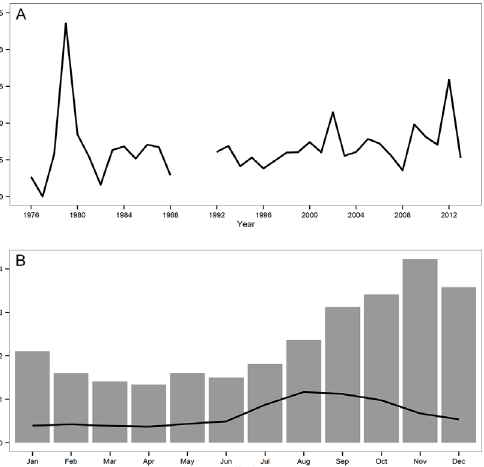
Fig 2. Marine mammal stranding rate by year (A) and month (B) from 1976 to 2013 (records of unidentified species are included). Gray line in (B) represents stranding rate by month after removing records of species with high mortality, migratory whales, neonates of South American fur seal and unidentified marine mammals. Y-axes in (B) are on a square-root scale for ease-of-read purpose. Only stranding records from areas 2 and 3 were